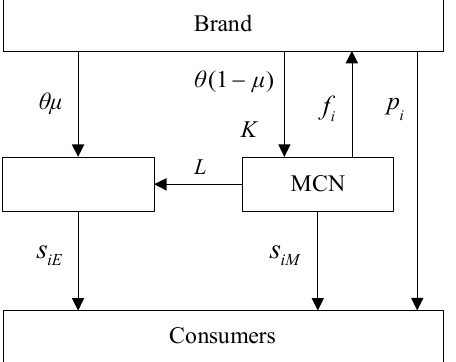
Figure 1. Illustration of live streaming e-commerce structure.